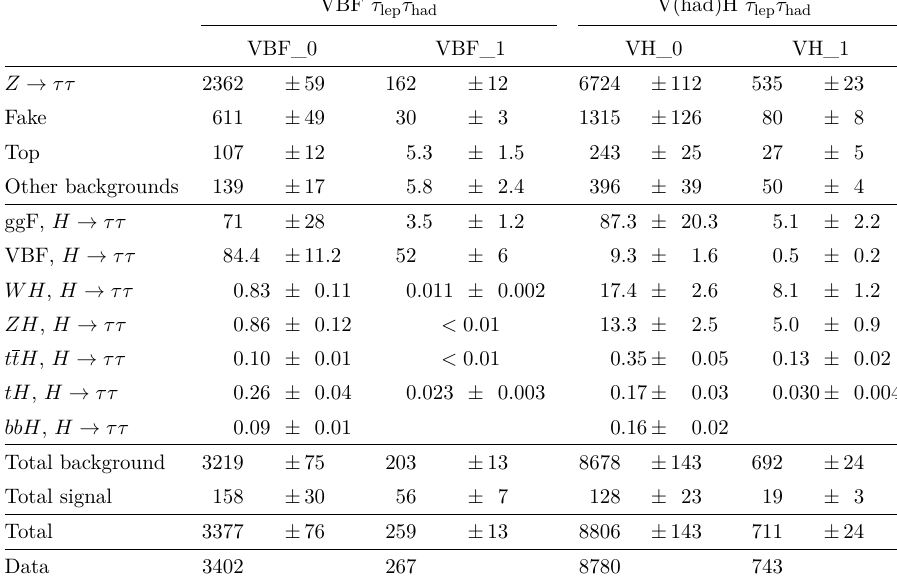
Table 9. Observed event yields and predictions as computed by the fit in the VBF and V(had)H signal regions of the τ τ channel. Uncertainties include statistical and systematic components. lep had The prediction for each sample is determined from the likelihood fit performed to measure the pp → H → ττ